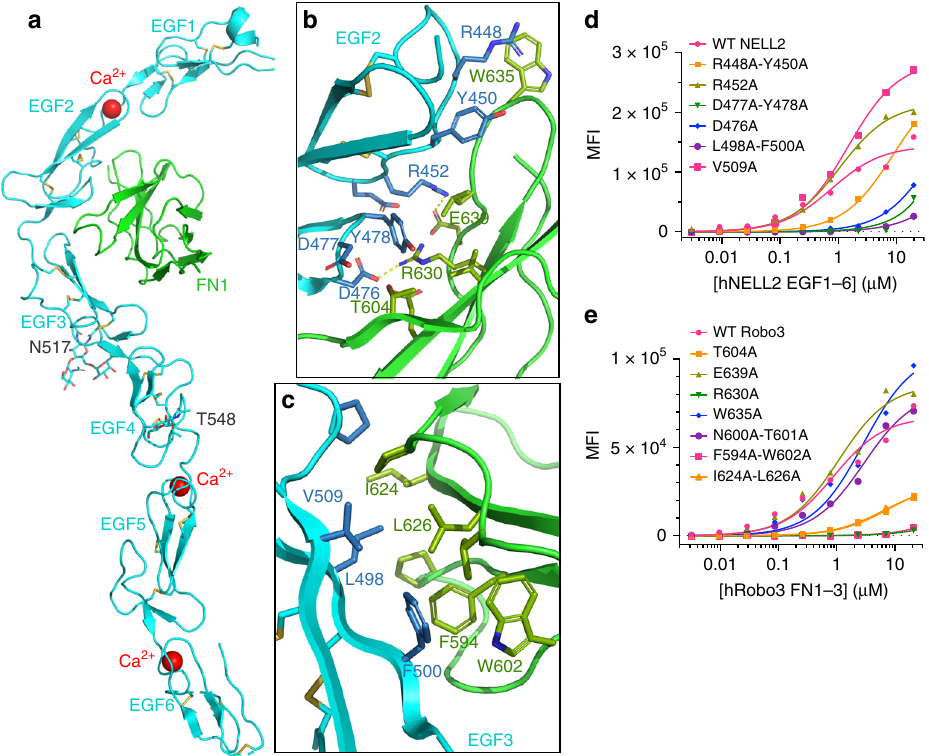
Fig. 3 Crystal structure of the NELL2 – Robo3 complex. a The structure of hRobo3 (green) bound to hNELL2 (cyan). The three calcium ions are depicted as balls; the two glycan moieties and the side chains they are linked to are shown as sticks. b Interactions of the EGF2 domain with Robo3 are dominated by polar contacts. c Interactions of the EGF3 domain with Robo3 are exclusively hydrophobic. d Binding isotherms for biotinylated wild type and mutant hNELL2 EGF1 – 6 measured against S2 cells expressing hRobo3 FN1 – 3. y -axis represents mean fl uorescence intensity (MFI) from fl uorescent streptavidin. e Binding isotherms for biotinylated wild type and mutant hRobo3 FN1 – 3 measured against S2 cells expressing hNELL2 EGF1 – 6. Apparent K D values for S2 cell staining experiments are listed in Supplementary Fig.